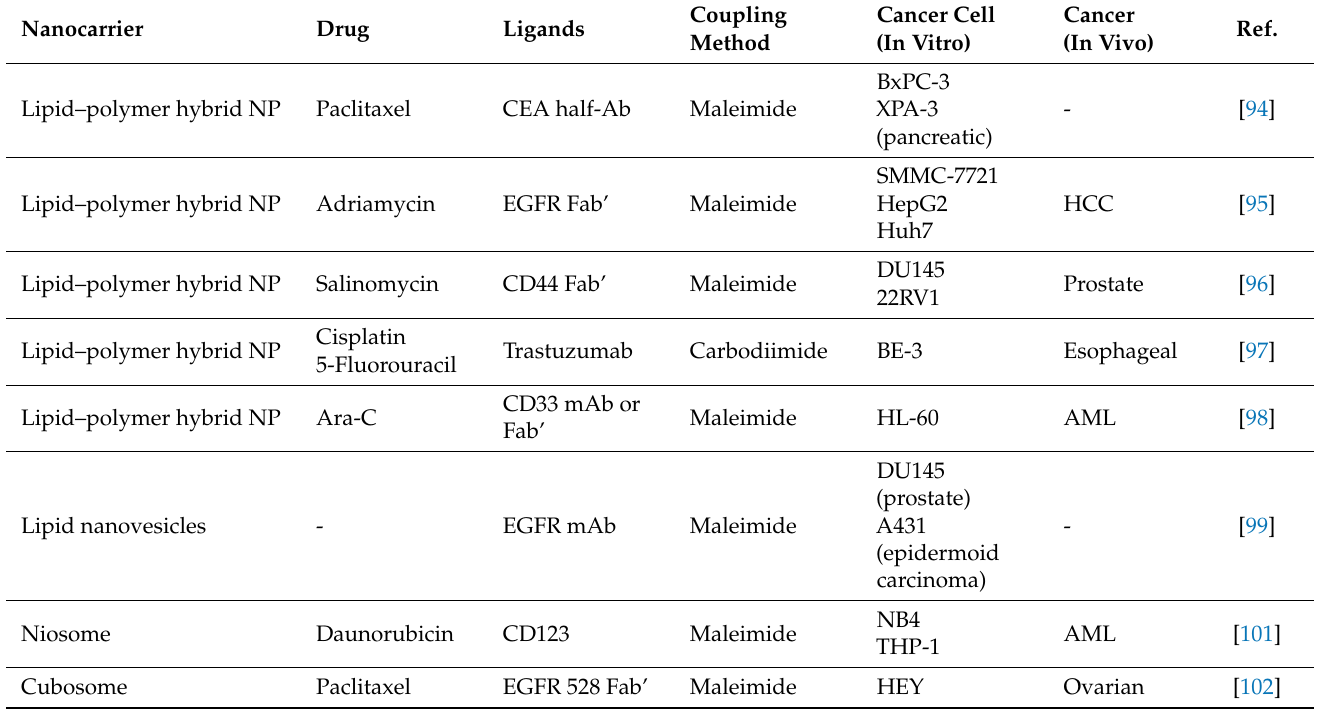
Table 4. Other antibody-functionalized lipid nanoparticles for anticancer drug